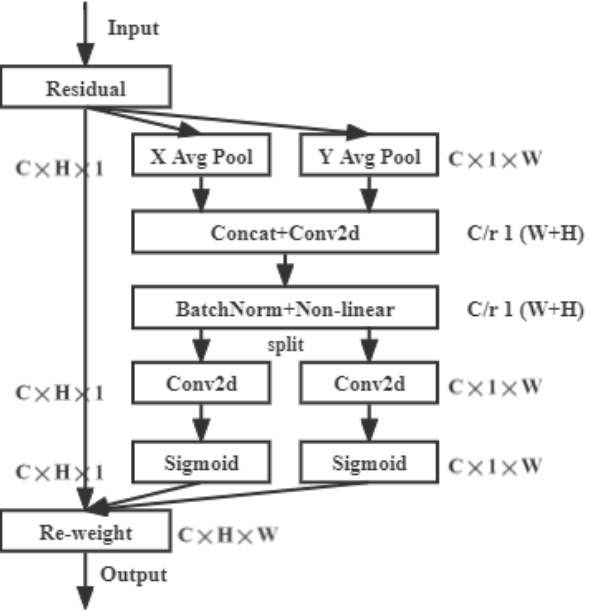
Figure 3. The structure of CA module.